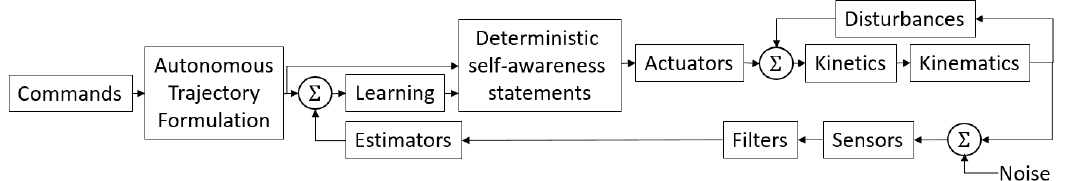
Figure 3. The system topology of deterministic artificial intelligence.